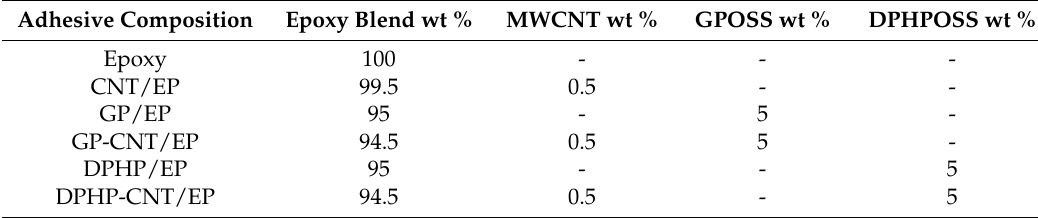
Table 2. Adhesive compound.